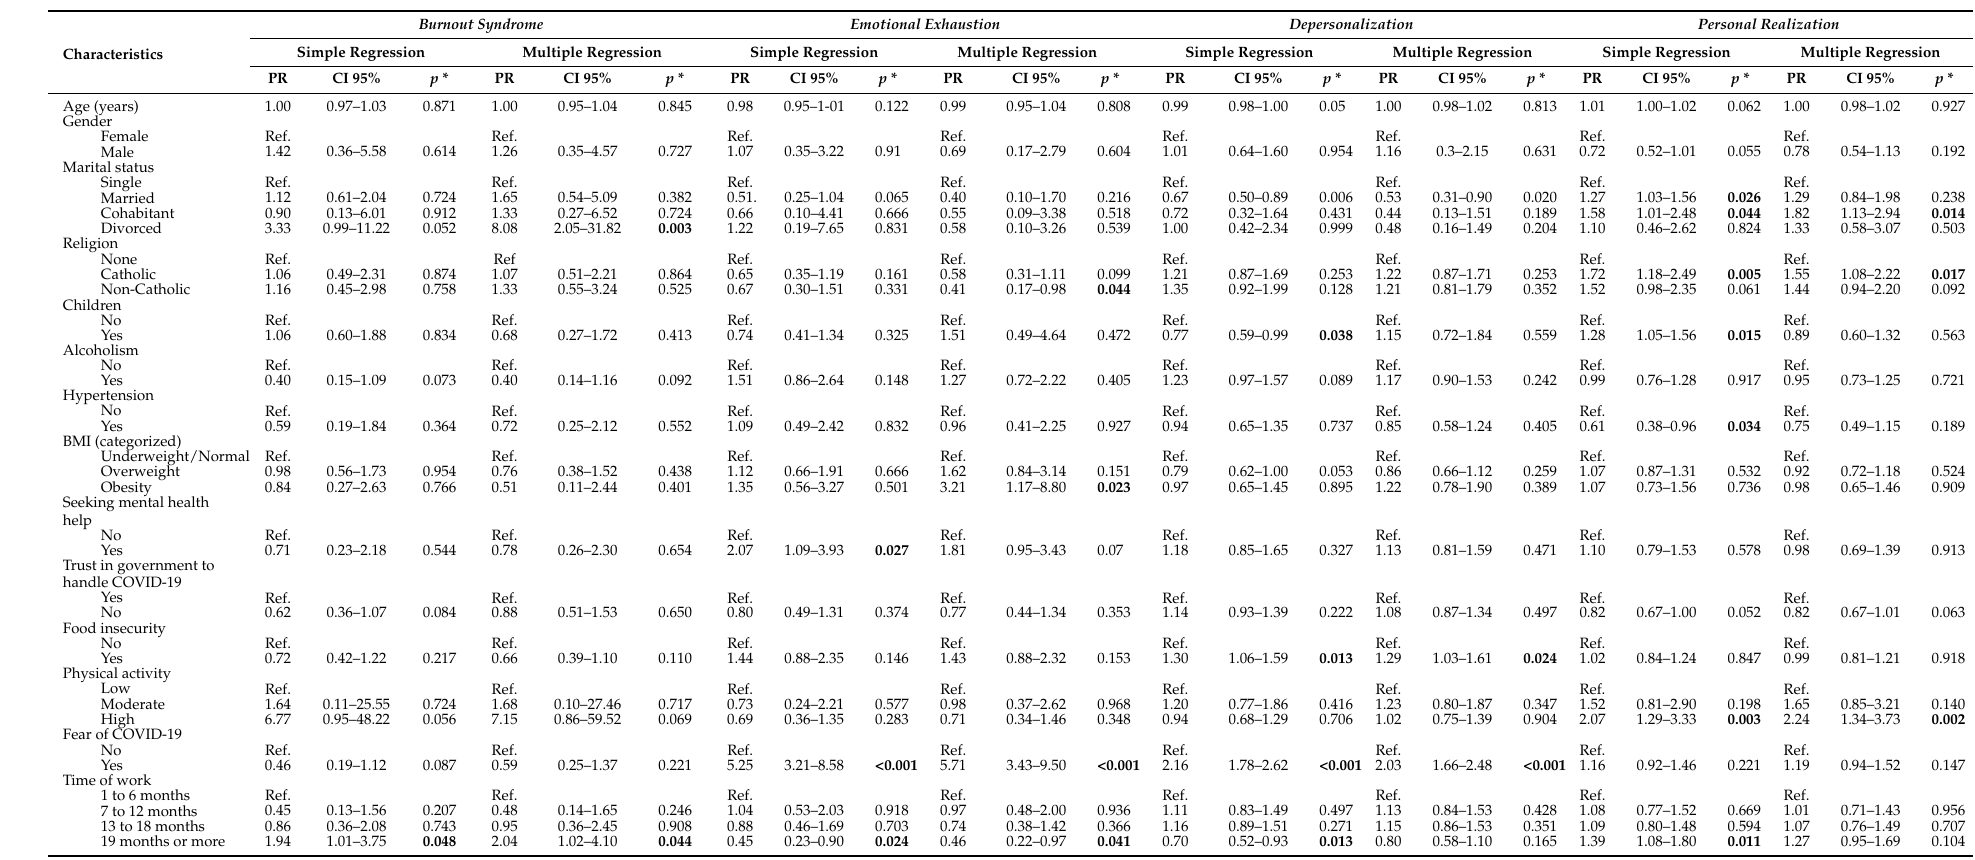
Table 3. Factors associated with burnout syndrome and its